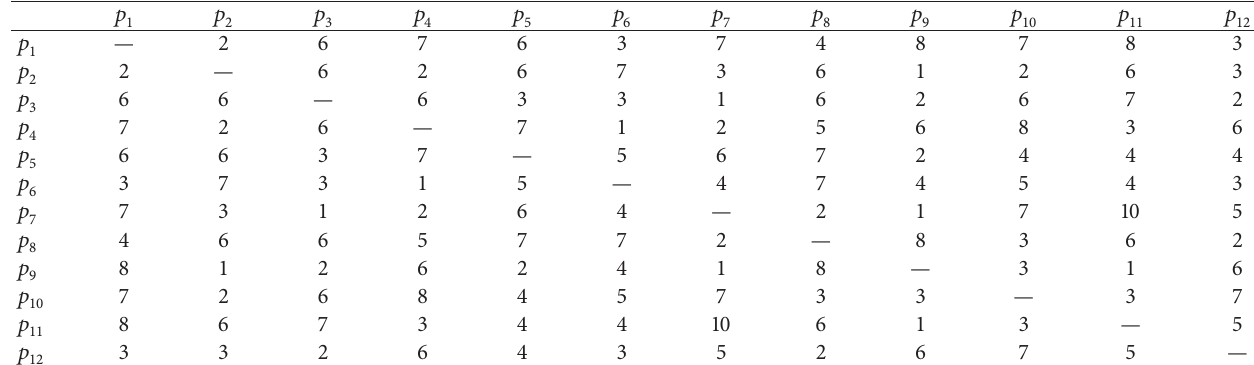
Table 3: Initial information of collaborative indicator 𝐶 1 of candidate units.